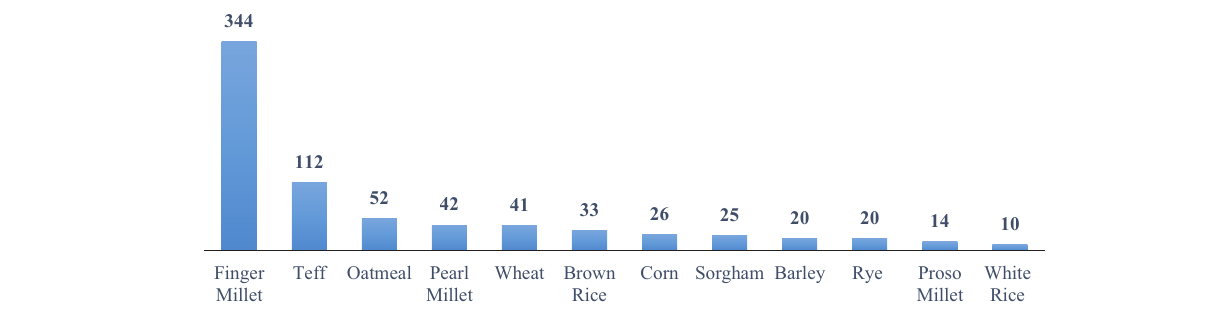
FIGURE 1 | Ca content of different crops (mg/100 g edible portion). Based on data provided by McKevith (2004), Saleh et al. (2013), and Shobana et al.